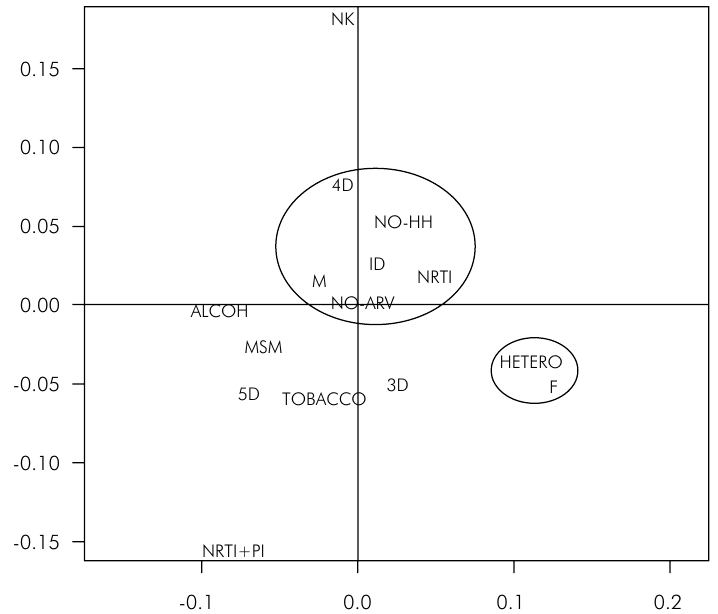
Figure 3. Correspondence analysis, from 1989 to 1992, lists the variables: age, harmful habits, HIV exposure category, gender and ARV.